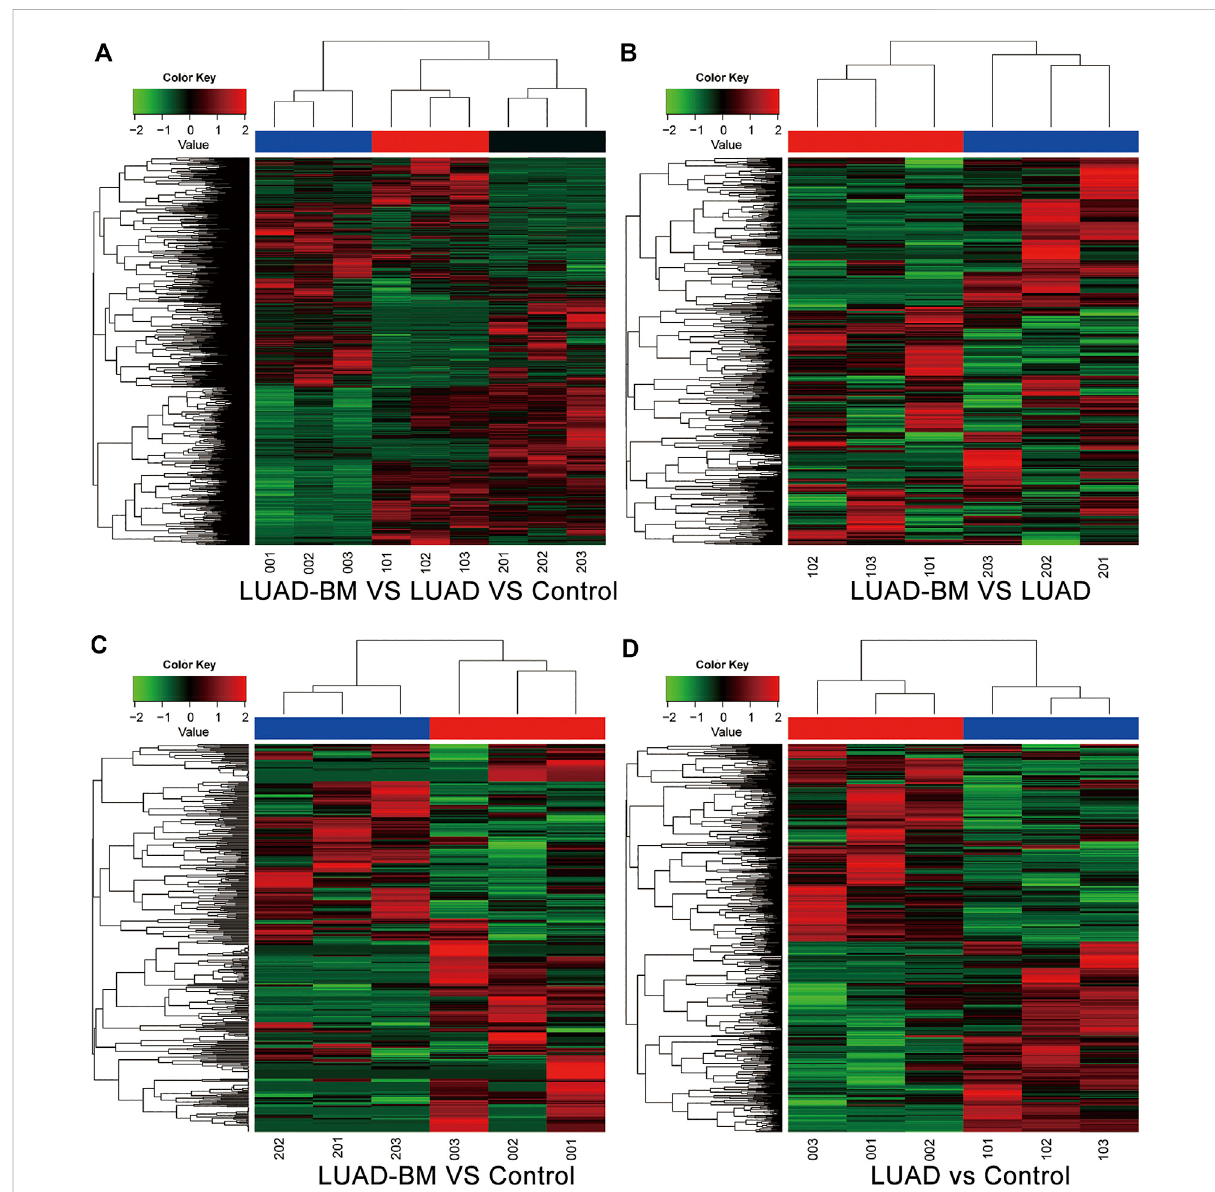
FIGURE 1 Hierarchicalclustering analysis of differentially expressed circRNAs among different groups. (A) The differentially expressed circRNAs ofLUAD- BM, LUAD, and control. (B) The differentially expressed circRNAs between LUAD-BM and LUAD. (C) The differentially expressed circRNAs between LUAD-BM and healthyindividuals. (D) The differentially expressed circRNAs between LUAD and healthy individuals. LUAD-BM: 201, 202,203;LUAD: 101, 102, 103; Control: 001, 002, 003. LUAD-BM, lung adenocarcinoma with bone metastasis; LUAD, lung adenocarcinoma; circRNAs, circular